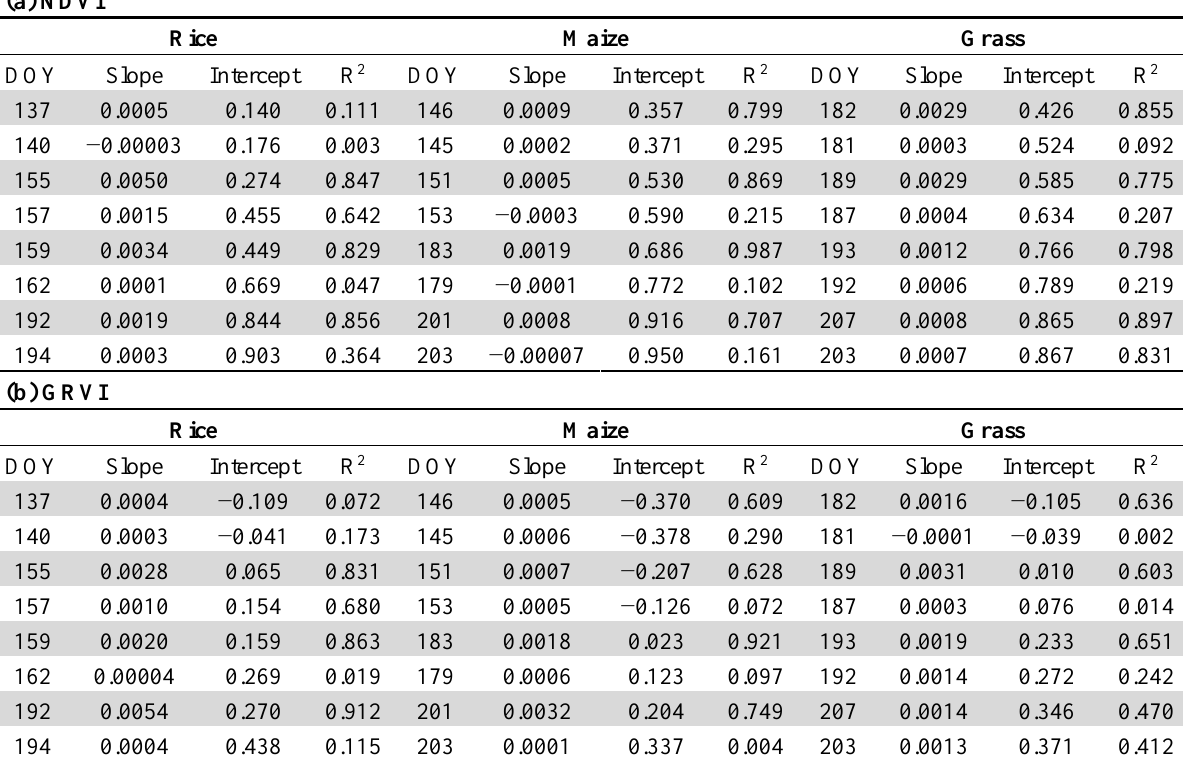
Rice Maize Grass